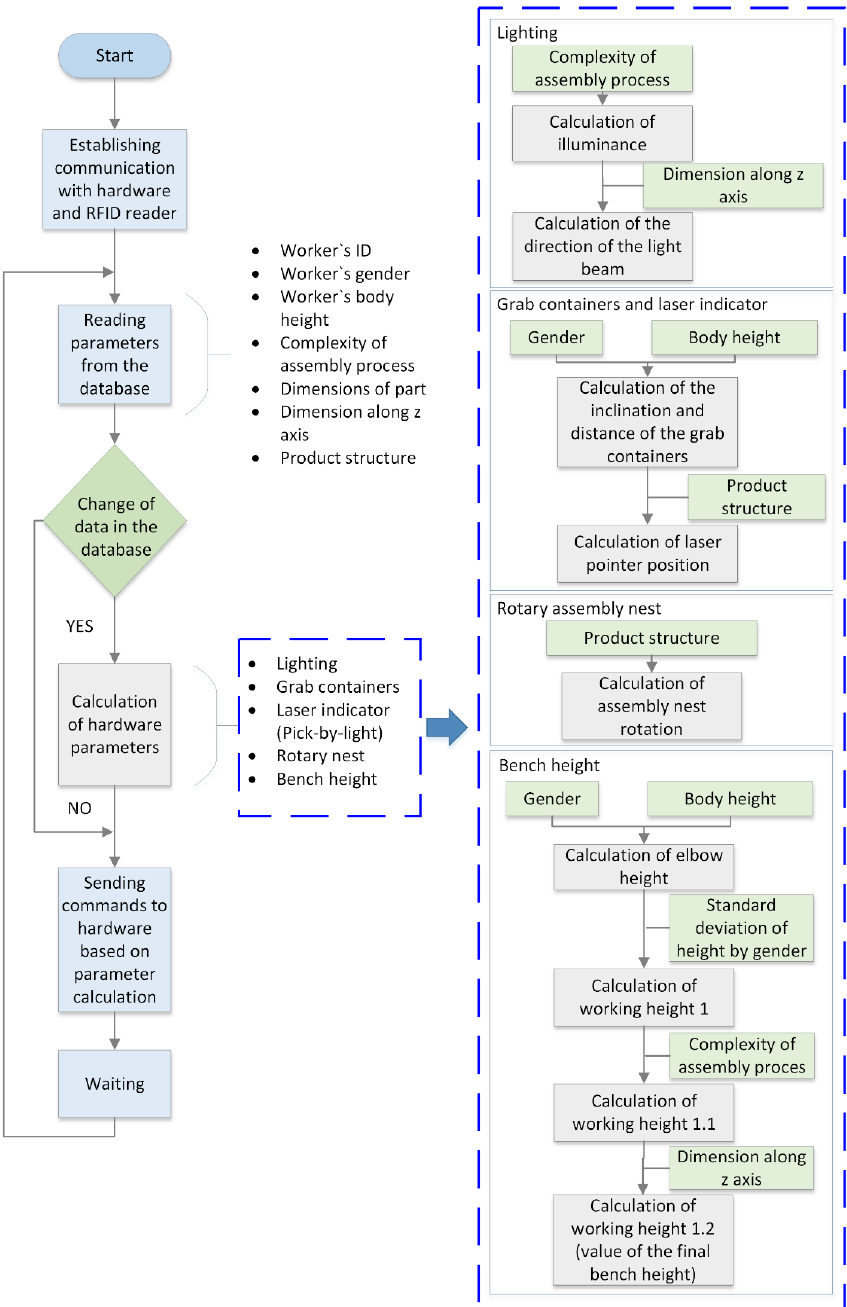
Figure 1. Block diagram of new multi-criterial algorithm and influential parameters.